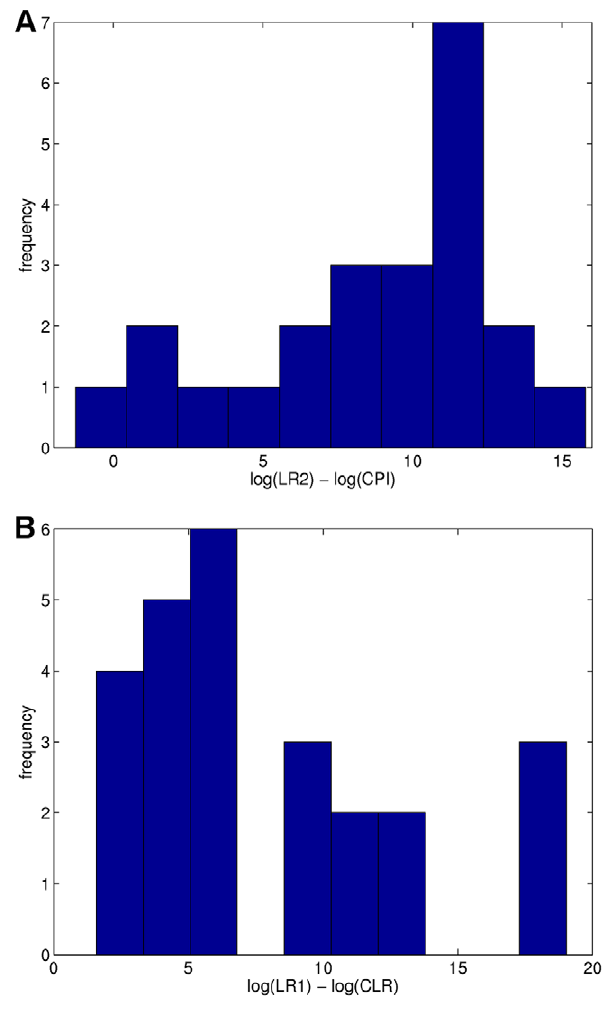
Figure 5. Histograms show how match information increases when using quantitative interpretation methods. The within- case log(LR) match information differences between quantitative and qualitative interpretation methods. (a) The information improvement log(LR2/CPI) between the LR2 (quantitative interpretation) and CPI (qualitative interpretation) match statistics on the same cases, when there are two unknown contributor genotypes. (b) The information improvement log(LR1/CLR) between the LR1 (quantitative method) and CLR (qualitative method) match statistics on the same cases, when the victim genotype is known, and there is one unknown contributor